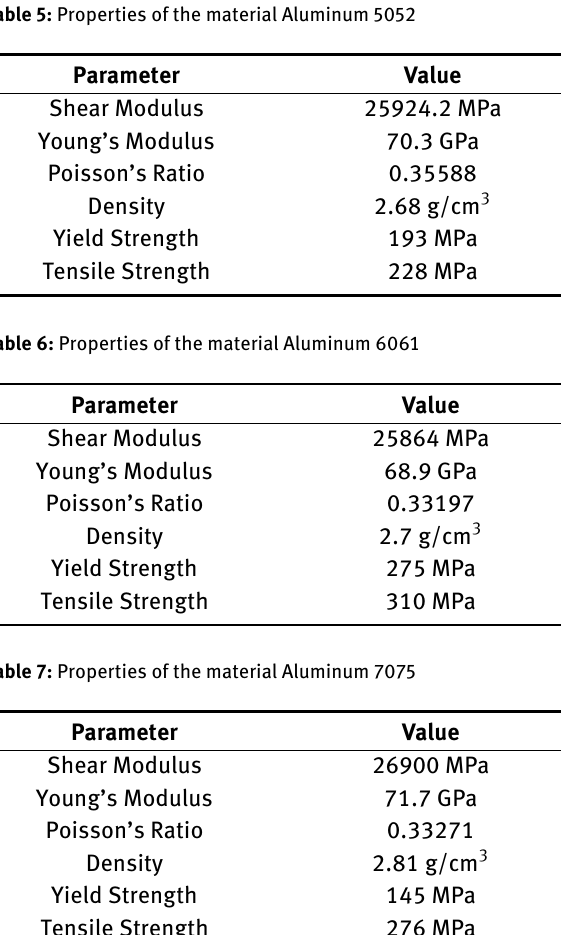
Table 5: Properties of the material Aluminum 5052